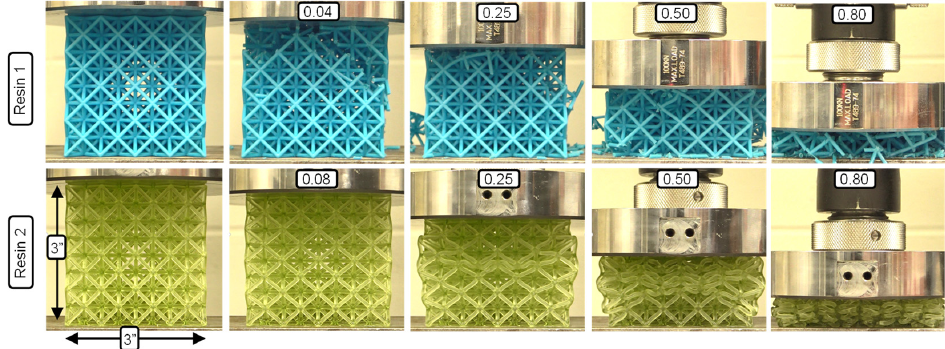
Figure 7. Compression test images for the 4 × 4 × 4 R1.0 lattice